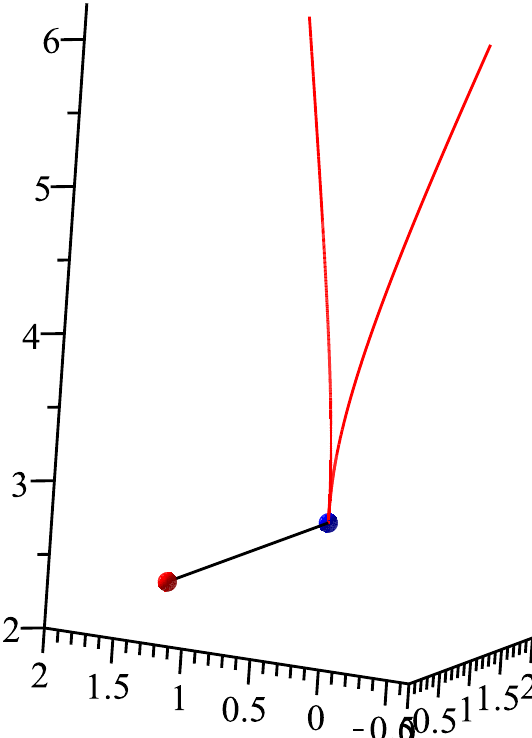
Figure 7. Geometric illustration for the test point p = (2.0, 2.0, 2.0) of Example